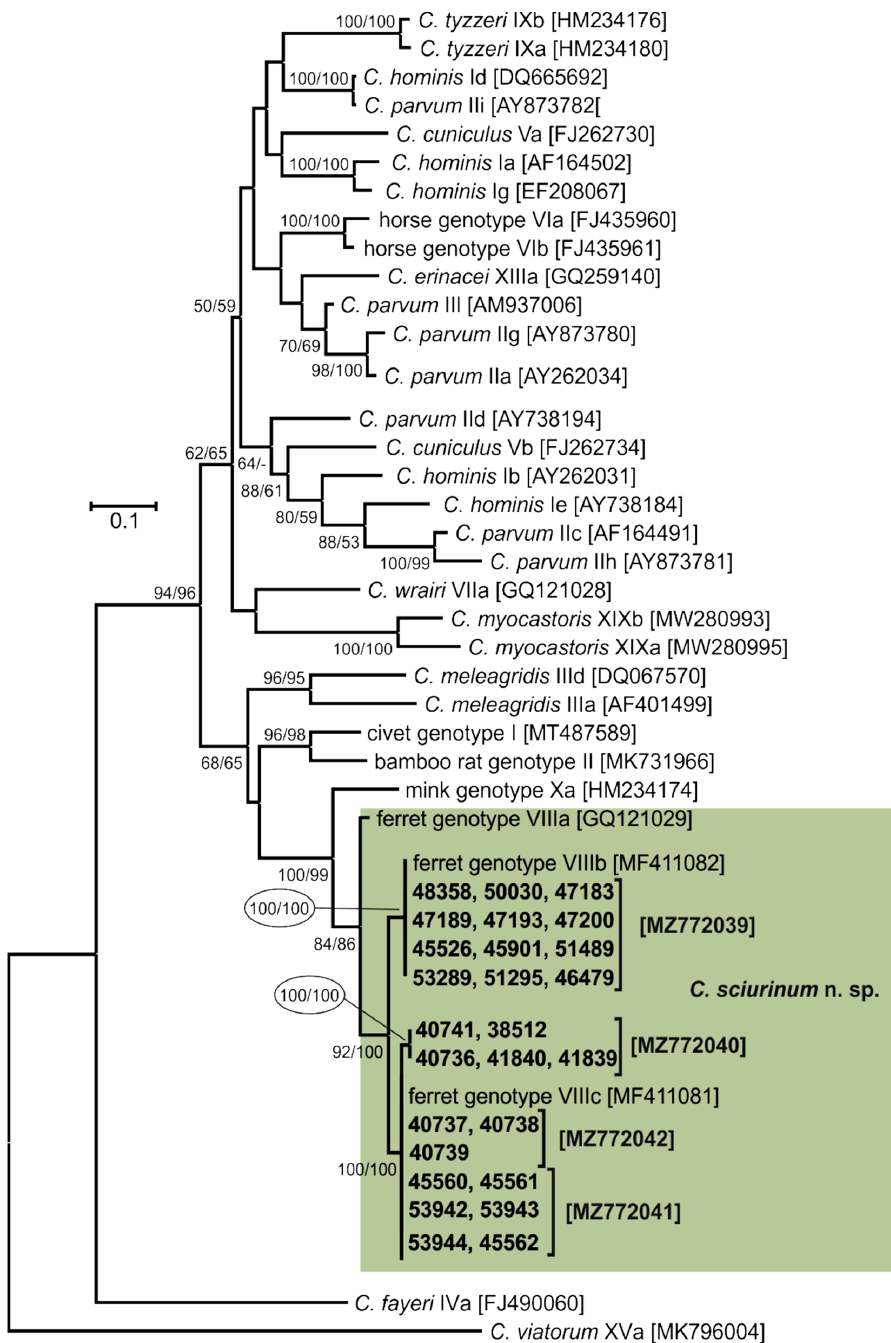
Figure 3. Evolutionary relationships of Cryptosporidium spp. at 60 kDa glycoprotein ( gp60 ) locus inferred by Maximum Likelihood (ML) and Neighbor-Joining (NJ) analyses using a General Time Reversible model with a gamma distribution: Percentage support (>50%) from 1000 pseudoreplicates from ML and NJ analysis, respectively, are indicated next to supported node. The ‘-’ indicates support value <50%. The tree is drawn to scale, with branch lengths in the same units as those of the evolutionary distances used to infer the phylogenetic tree. The analysis involved 58 nucleotide sequences and there were a total of 1134 positions in the final dataset. The tree was rooted with the gp60 sequence of Cryptosporidium viatorum [MK796004]. Sequences obtained in this study are identified by isolate number (e.g., 45901). The GenBank Accession number is in parenthesis. Isolates detected in this study are colour-coded.